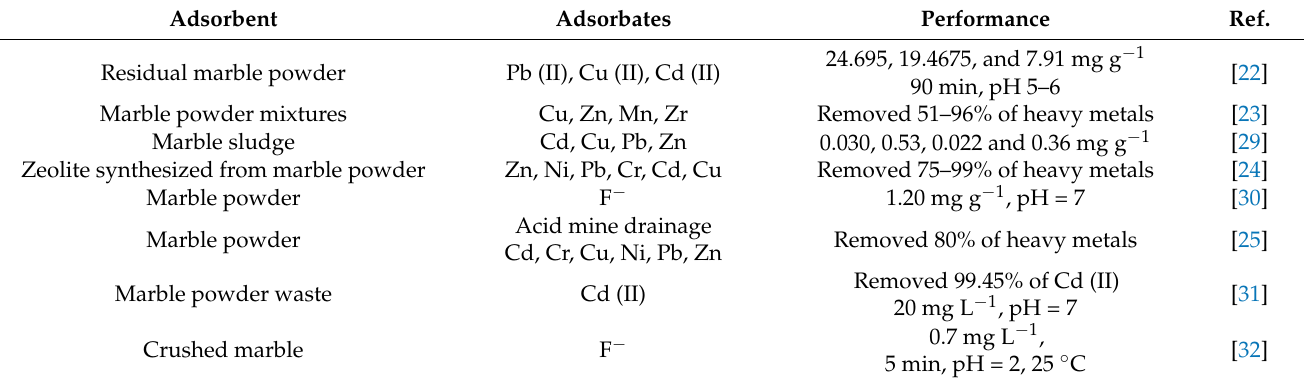
Table 1. Literature review of alternative adsorbents derived from marble